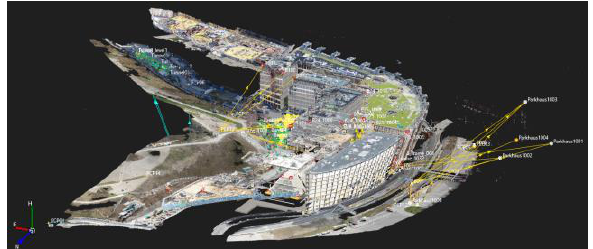
Table 1 . GCPs coordinates and quality.